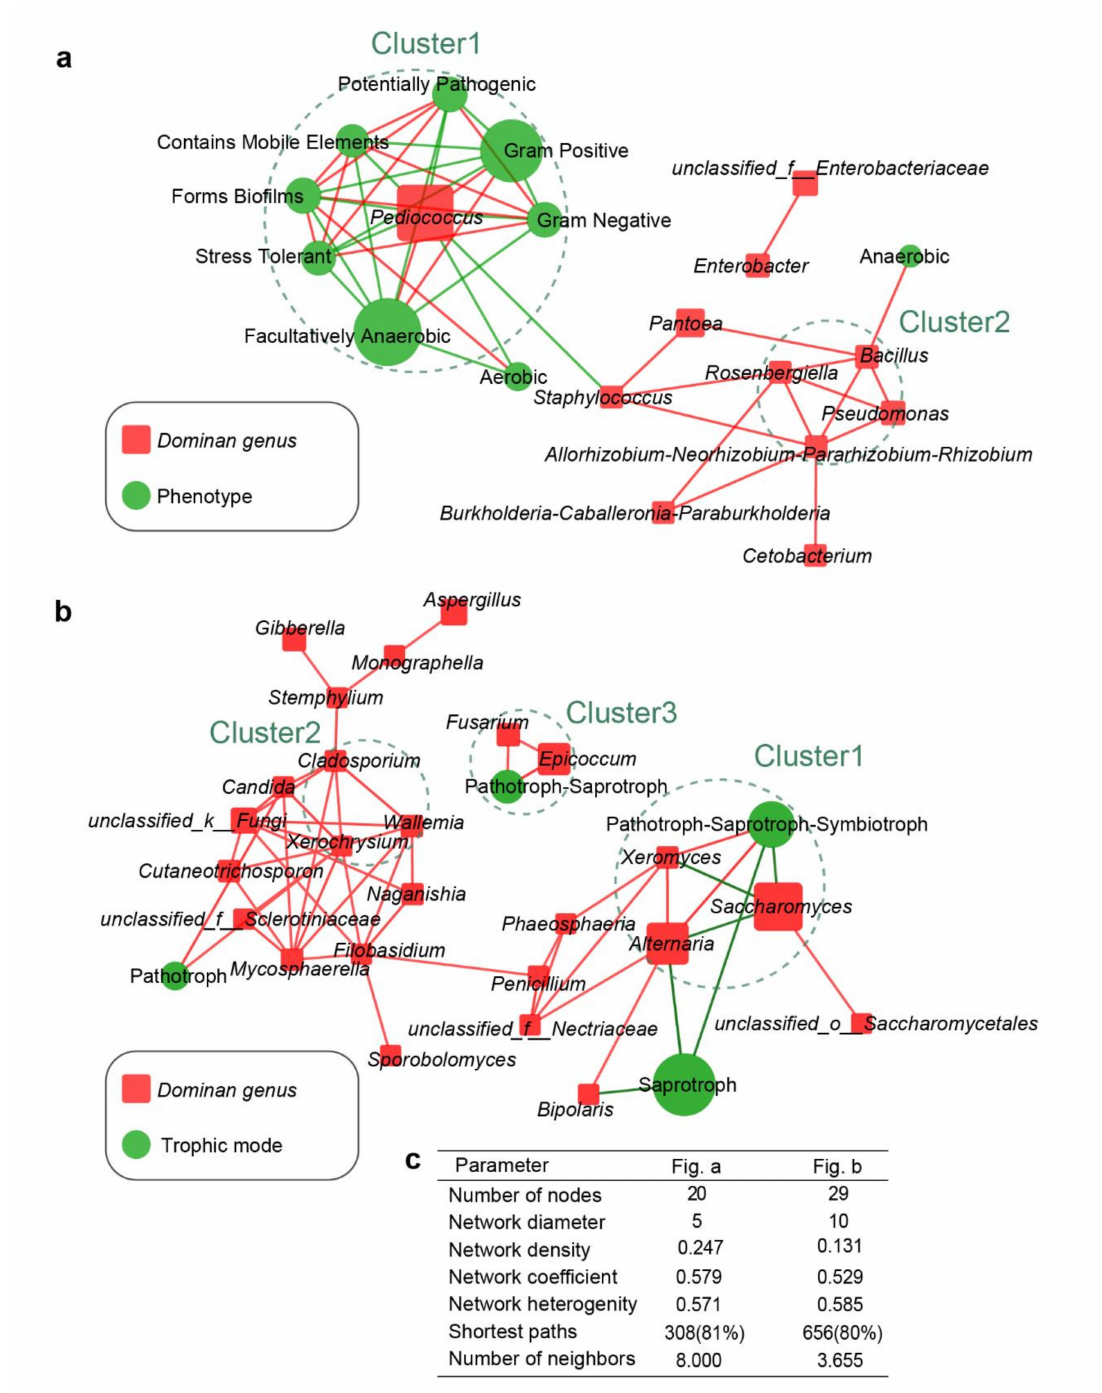
Figure 5. Network analysis based on the correlation between microflora and microflora characteristics. ( a ) Bacterial community phenotypes and bacterial genera. ( b ) Fungal community trophic mode and fungal genera. Red edges: positive correlation; green edges: negative correlation; the size of nodes indicates the average relative abundance of the genera/phenotypes/trophic modes. ( c ) The topological parameters of